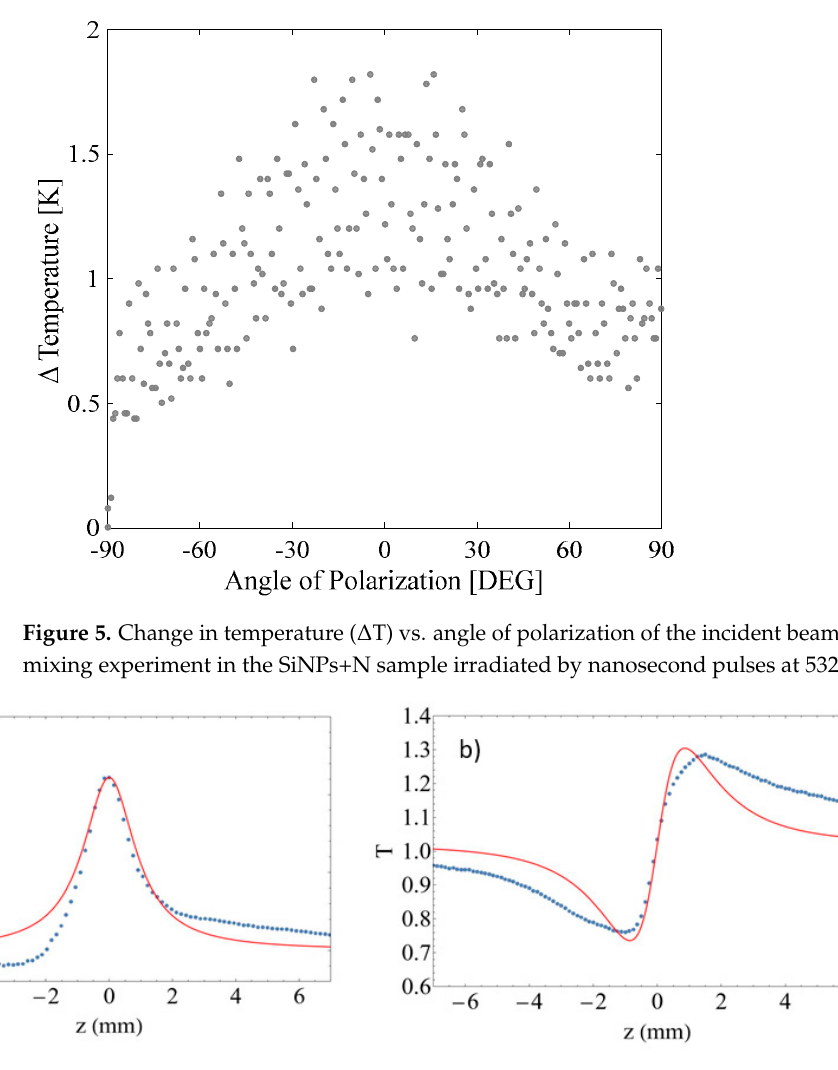
Figure 6. Z-scan results obtained with 98 fs pulses at 800 nm using a 300 mW average power (cor- responding to a pulse energy of 4 nJ); ( a ) open-aperture results, showing the signature of saturable absorption, and ( b ) closed-aperture z-scan , showing a positive nonlinear refractive index. Dot lines represent experimental data and solid lines correspond to numerical fiting.